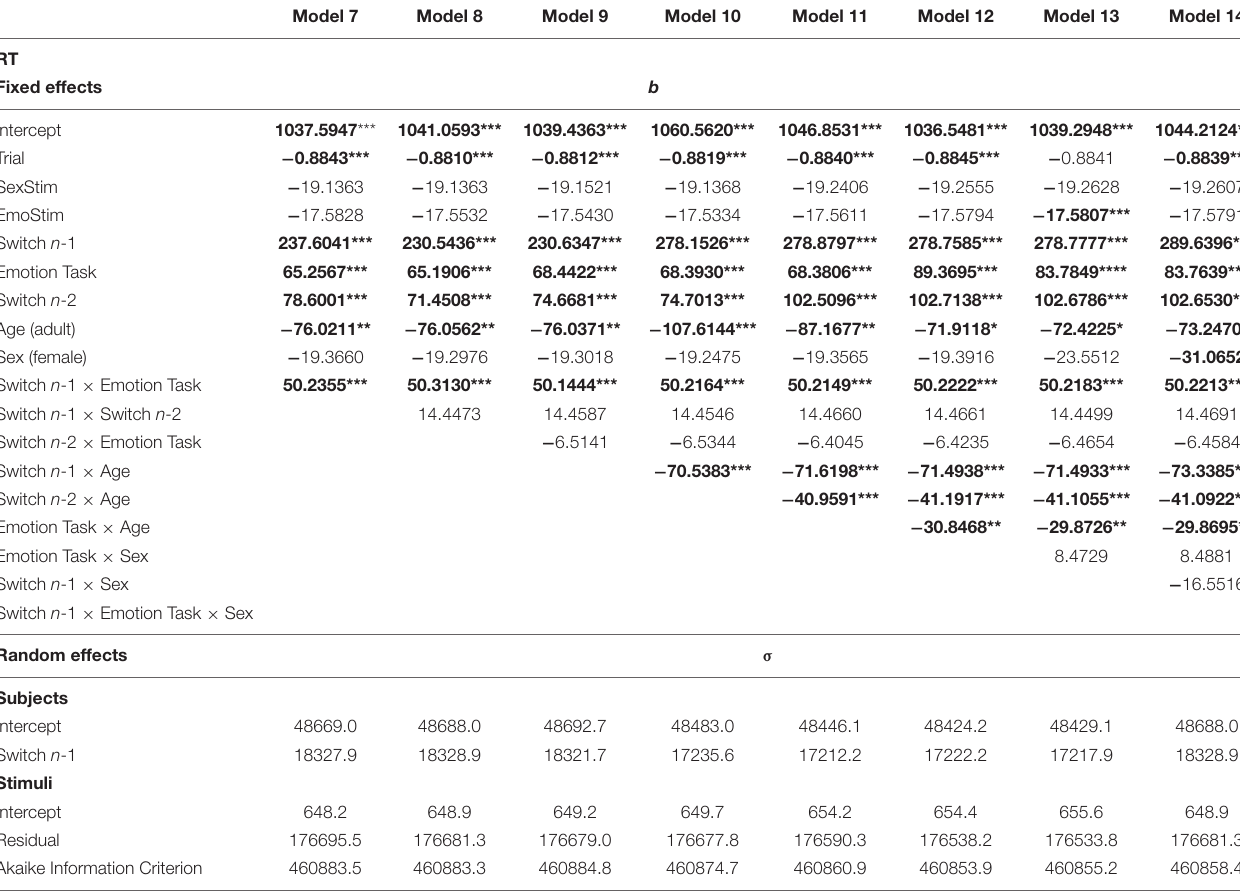
TABLE 4 | Linear Mixed Models results for models 7 to